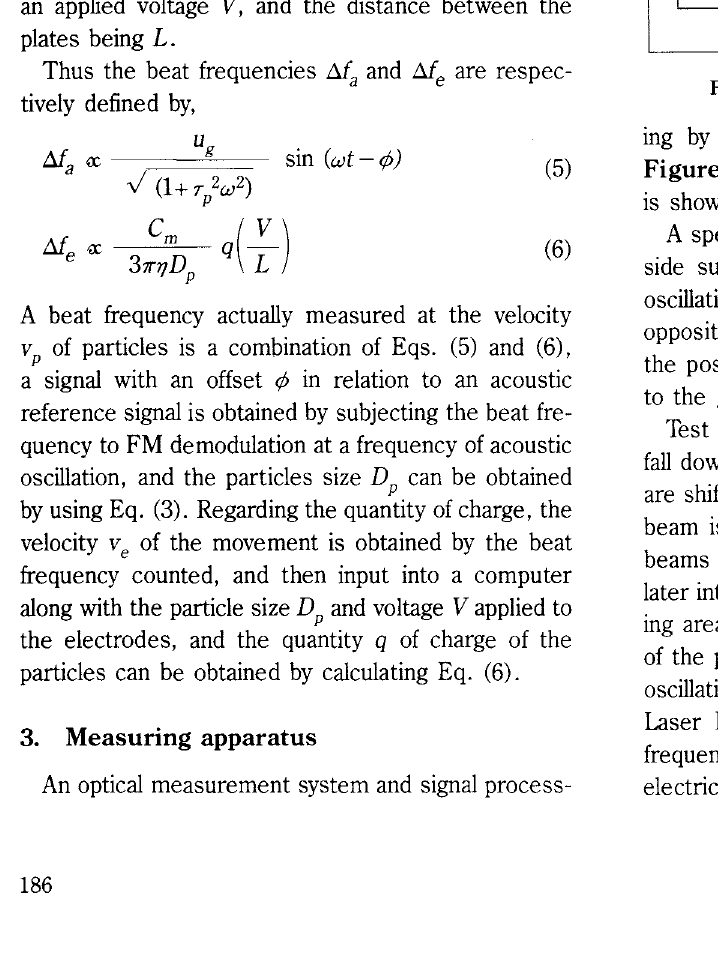
Fig. 3 Block diagram of measurement